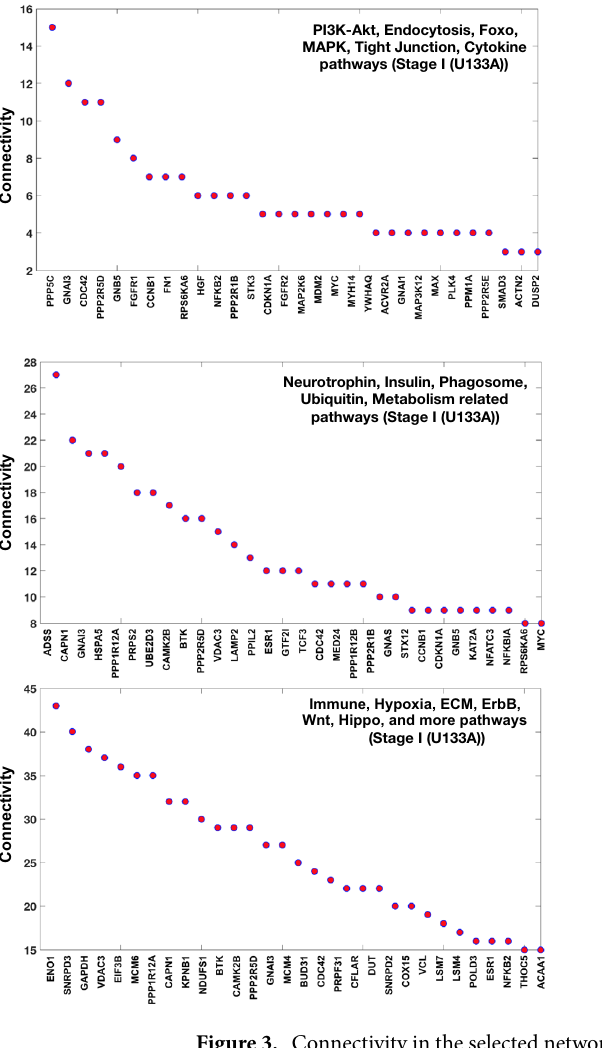
Figure 3. Connectivity in the selected networks (where the gene connectivity is not visible), for the top 30 genes matched with those pathways which are enriched for the DEGs list. ( a – f ) Connectivity of the genes